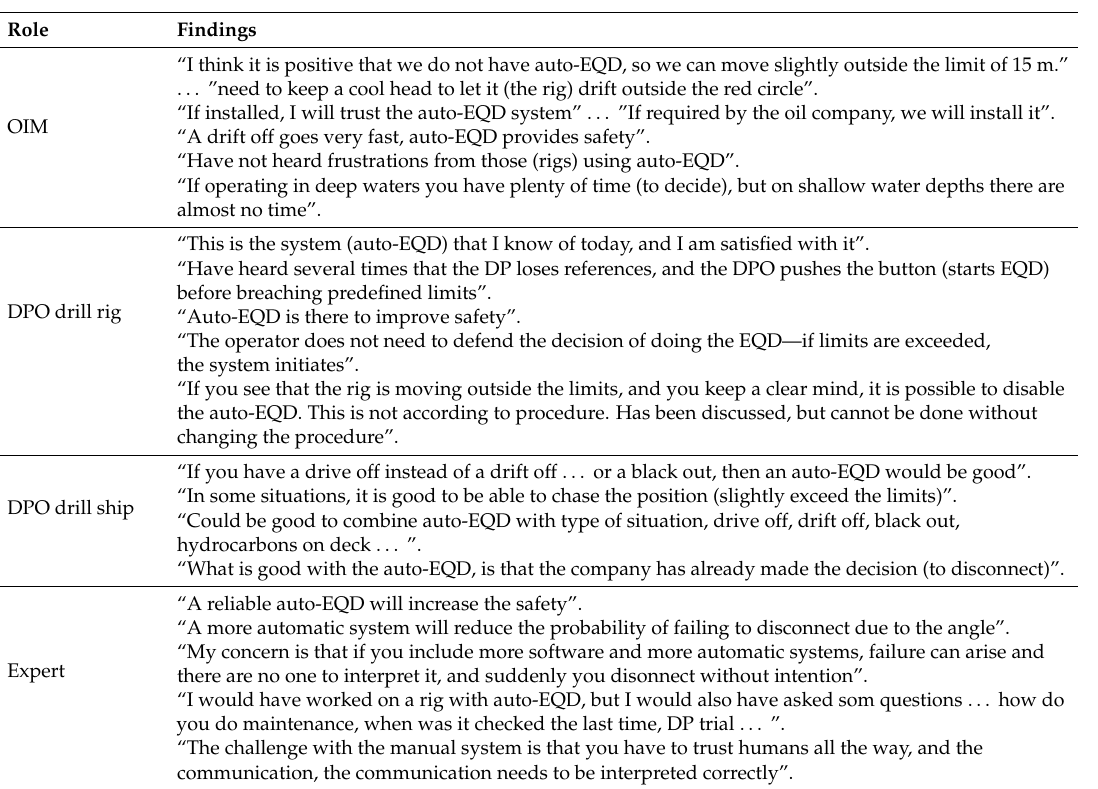
Table 6. Interview findings about the use of